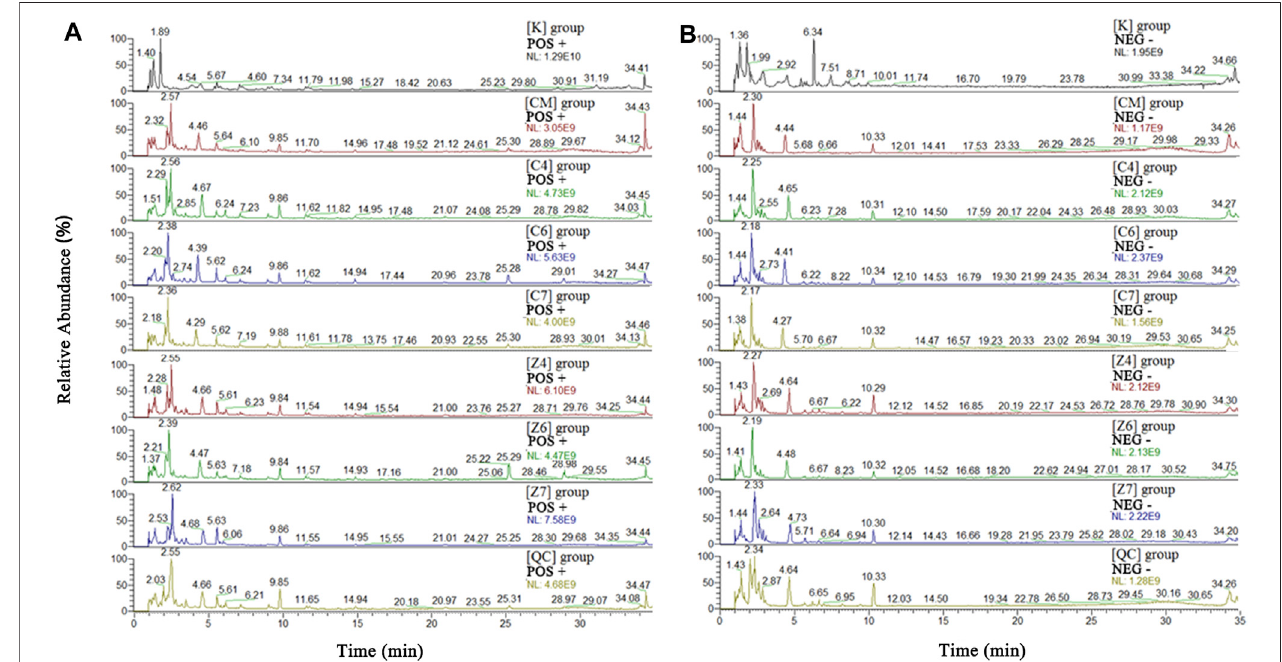
FIGURE 3 | Total ions chromatograph (TIC) in positive (A) and negative (B) ion of [K], [CM], [C1] – [C7], [Z1] – [Z7]and [QC] group. [CM] CUMS rats, [K] control rats, [C1] ∼ [C7] CUMS rats given PBR (7 different dosages), [Z1] ∼ [Z7] control rats administered PBR, and [CY] CUMS rats administered venlafaxine